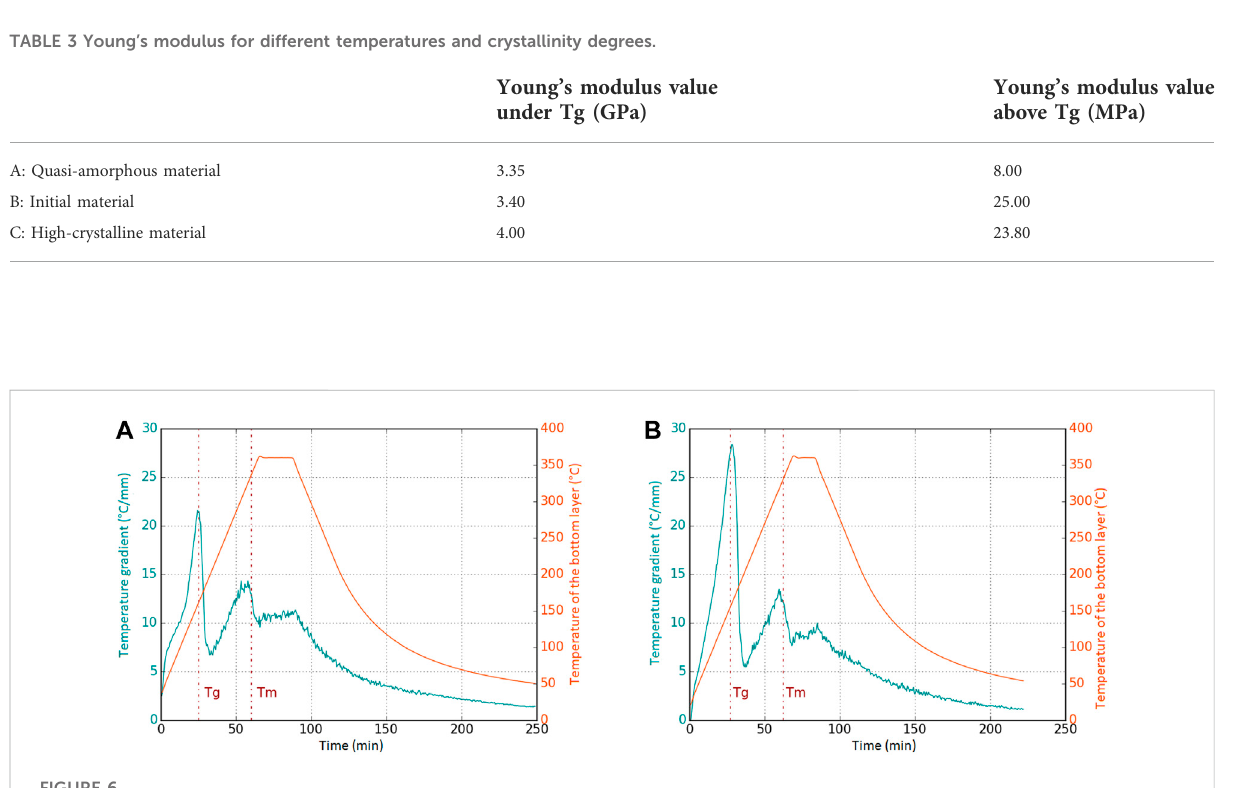
Young ’ s modulus value under Tg (GPa)